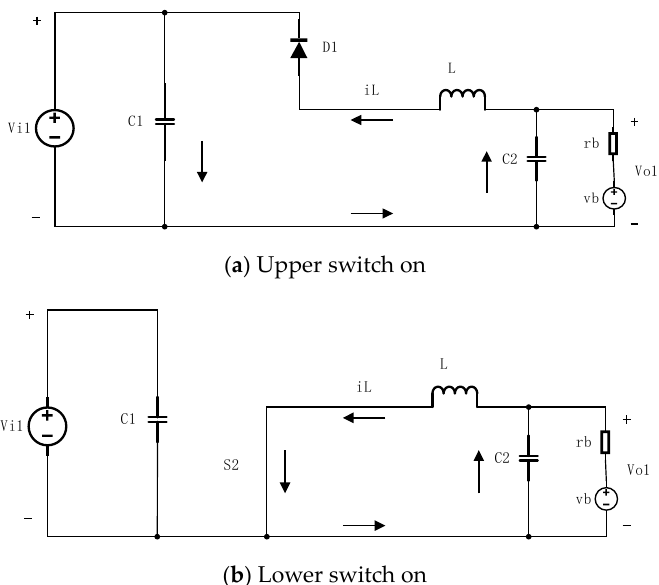
Figure 6. Equivalent circuit in boost